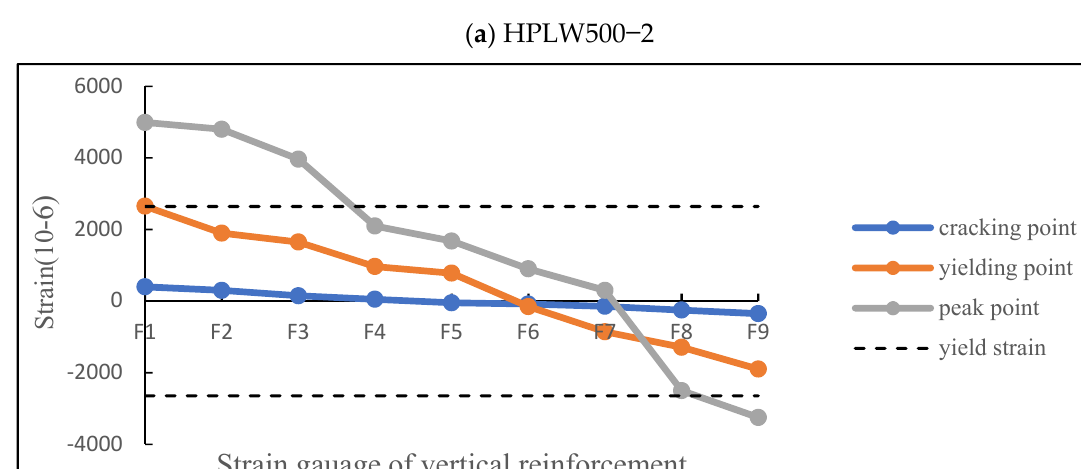
( b ) HPLW800 − 1 Figure 15. Horizontal reinforcement strain distributions along the wall height. As we can see from Figure 14, the vertical reinforcement strains along the wall length were strictly linearly distributed at the yielding-point state, and the strains were approxi- mately linearly distributed at the peak-point state. Therefore, the plane cross-section as- sumption may be used in the design of short-limb shear walls with an L-shaped section. As exhibited in Figure 15, most of the horizontal rebars were yielded. The yielded stirrups were mainly concentrated in the middle and lower parts of the web, indicating that the shear damage was mainly concentrated in the middle and lower part of the web, and the flange had little effect on improving the shear capacity. All high-strength stirrups at the free web boundary were yielded, indicating that the use of high-strength stirrups can strongly limit the lateral deformation of specimens and prevent premature failure of the web under compression.